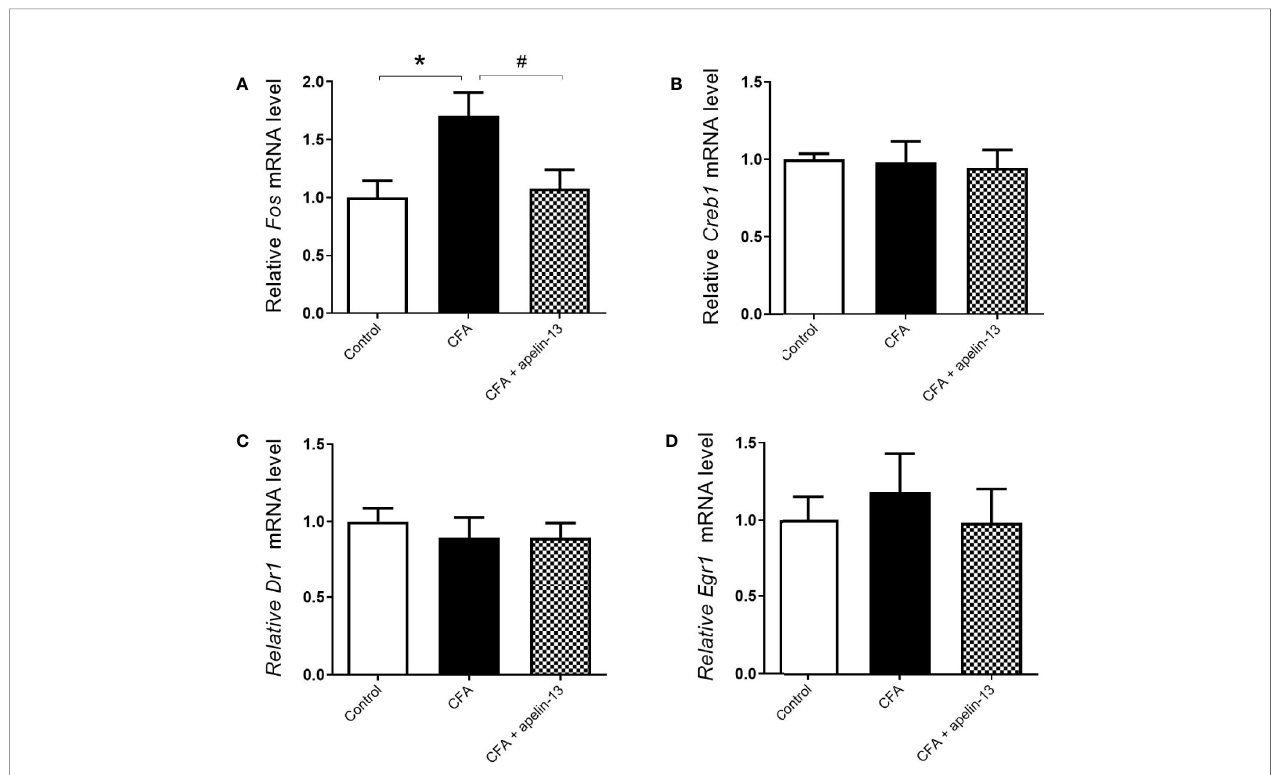
FIGURE 5 | Effect i.t. apelin-13 on the c-Fos , Creb1 , Dr1 and Egr1 gene expression in mouse L4/5 spinal cord. mRNA expression levels of Fos (A) , Creb1 (B) , Dr1 (C) and Egr1 (D) were determined by real-time qPCR and normalized with the housekeeping gene 36B4 mRNA expression. Data are expressed as means ± SEM. * p < 0.05, compared with vehicle control (i.d. NS + i.t. NS); # p < 0.05, compared with CFA group (i.d. CFA + i.t. NS). n = 8 or 9 per